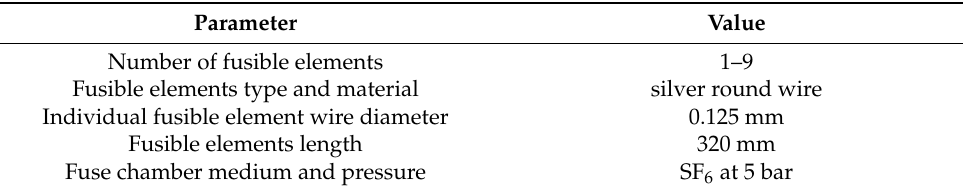
Table 2. Forming fuse laboratory model parameters.